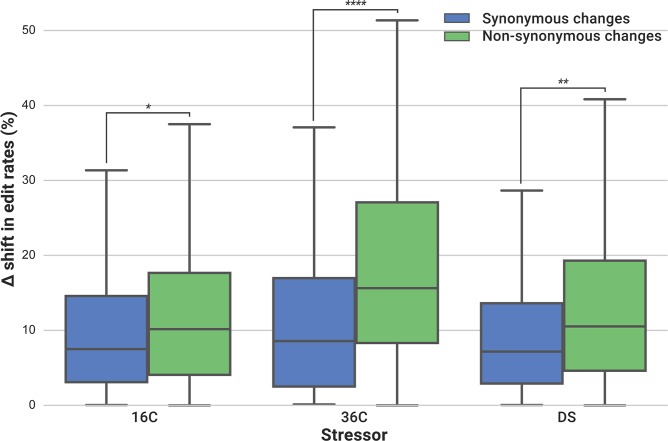
Non-synonymous changes predominate in coding regions of differentially edited genes.Delta shifts were calculated as the absolute difference of means between stressed and control samples (n ≥ 3 per condition). Shifts in edit frequencies at positions that lead to non-synonymous changes (green) are significantly higher than synonymous ones (blue) for all tested stressors: cold (“16C”), heat (“36C”) and dark (“DS”). p-values were computed from inter-group two-tailed t-tests (*: p < 0.05; **: p < 0.01; ****: p < 0.0001).